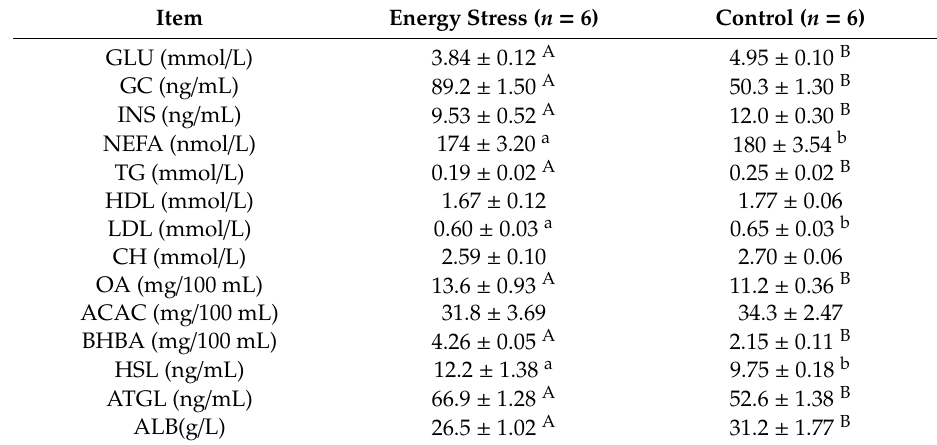
Table 3. The concentrations of metabolites and enzymes in the serum of the yaks in the energy stress (ES) group and control (CO)